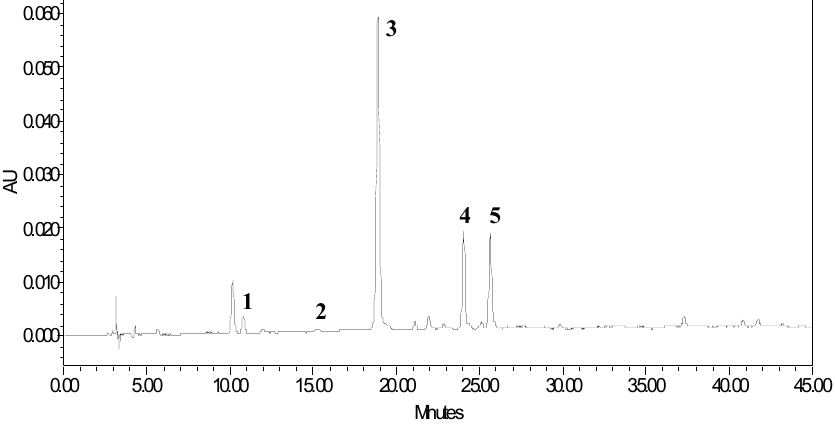
Figure 4. HPLC chromatographic profile of thiolysis products of proanthocyanidins. Catechin, 1 ; epicatechin, 2 ; catechin thioether, 3 ; epicatechin thioether, 4 ; (epi)catechin gallate thioether, 5